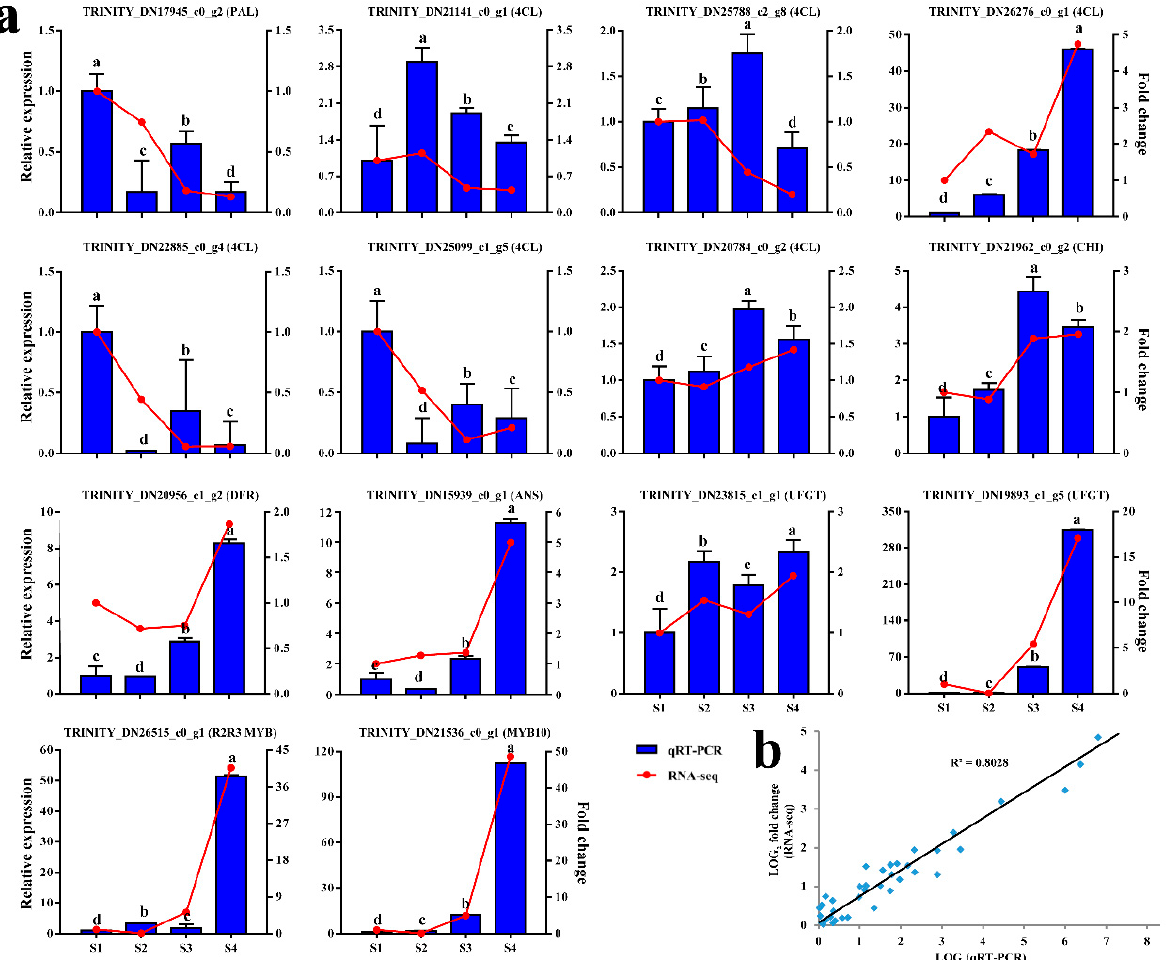
Figure 5. QRT-PCR validation of representative anthocyanin-related genes in fruit peel development. ( a ) The left y -axis indicates the corresponding expression data from qRT-PCR (blue histogram). The right y -axis shows the relative gene expression level measured by RNA-seq (red lines). Chactin was used as reference gene for normalization. All gene expression levels in S1 were set to 1. ( b ) Correlation of the expression levels of 14 selected genes measured by qRT-PCR and RNA-seq values for mean expression and standard errors (SE, n = 3) indicated by vertical bars. Lowercase letters indicate significant differences at p < 0.05. Gene names including phenylalanine ammonia-lyase (PAL), 4-coumarate-CoA ligase (4CL), chalcone isomerase (CHI), dihydroflavonol 4-reductase (DFR), anthocyanidin synthase (ANS) and UDP-glucose: flavonoid-3- O -glycosyltranferase (UFGT).